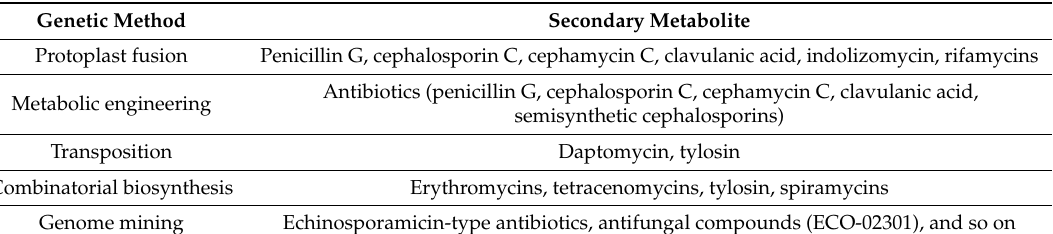
Table 2. Genetic methods applied to improve the production of antibiotics and β –lactamase inhibitors (Adapted from Adrio and Demain